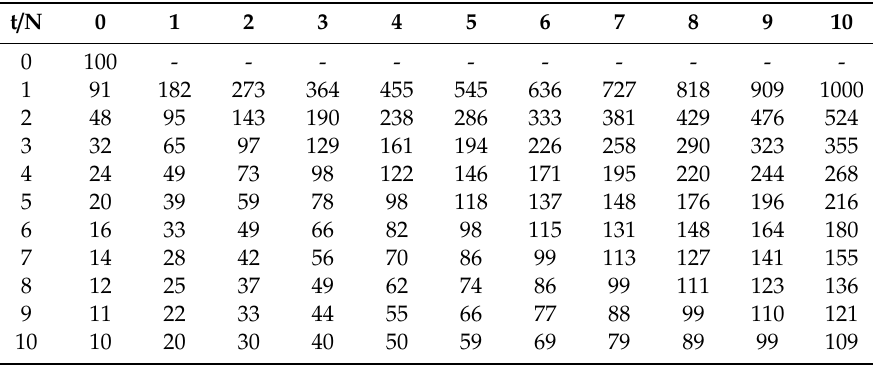
Table 5. Optimal Bonus-Malus System (BMS) based on the posteriori frequency component